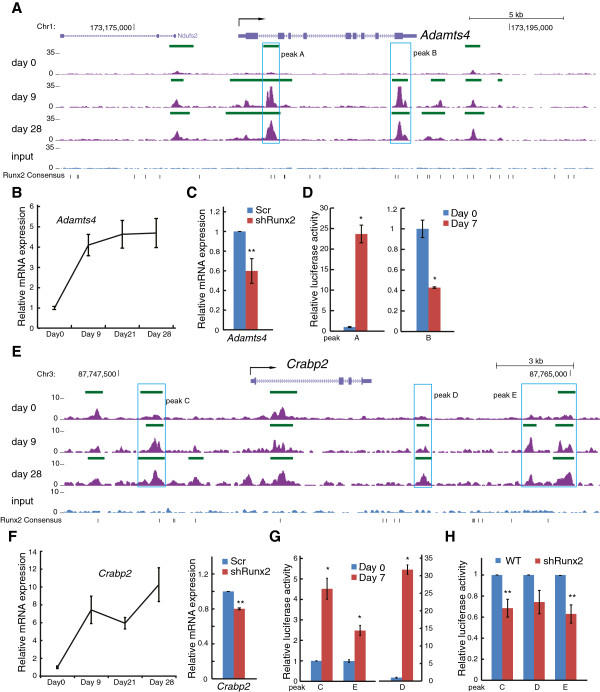
Non-promoter association of Runx2 regulates novel targets Adamts4 and Crabp2. (A) Increasing Runx2 enrichment was observed in the first intron (peak A, boxed region) and last exon (peak B, boxed region) of the Adamts4 locus during osteogenic differentiation. (B) Adamts4 mRNA levels (normalized to Hprt1) were significantly upregulated (P < 0.05) in differentiating MC3T3-E1 cells (days 9 to 28) when compared to proliferating cells (day 0). (C) Runx2 knockdown (shRunx2) decreases Adamts4 expression, compared to a scrambled shRNA (Scr) control (**P < 0.05). (D) DNA sequences identical to peak regions A and B were cloned into individual pGL2-SV40-Luc reporters and relative luciferase activity was measured in transfected MC3T3-E1 cells and significant increases and decreases (*P < 0.01) in luciferase activity were observed for peak A and B reporters, respectively. (E) Increasing Runx2 enrichment was observed up- (peak C) and downstream (peaks D and E) of the Crabp2 locus during osteogenic differentiation. (F) Crabp2 expression increases during differentiation. Knockdown of Runx2 (by shRunx2) significantly reduces (**P < 0.05) the endogenous expression of Crabp2 (right panel). (G) DNA sequences identical to peak regions C, D and E were cloned into individual pGL2-SV40-Luc reporters and relative luciferase activity was measured in transfected MC3T3-E1 cells at days 0 and 7 (*P < 0.01). (H) Runx2 knockdown by inducible shRNA results in a significant decrease (**P < 0.05) of luciferase activity mediated by peak C and E regions and a downward trend (P = 0.08) in luciferase activity regulated by peak D region. Statistical significance for all experiments was determined by Student’s t-test from mean ± SEM from three biological replicates.